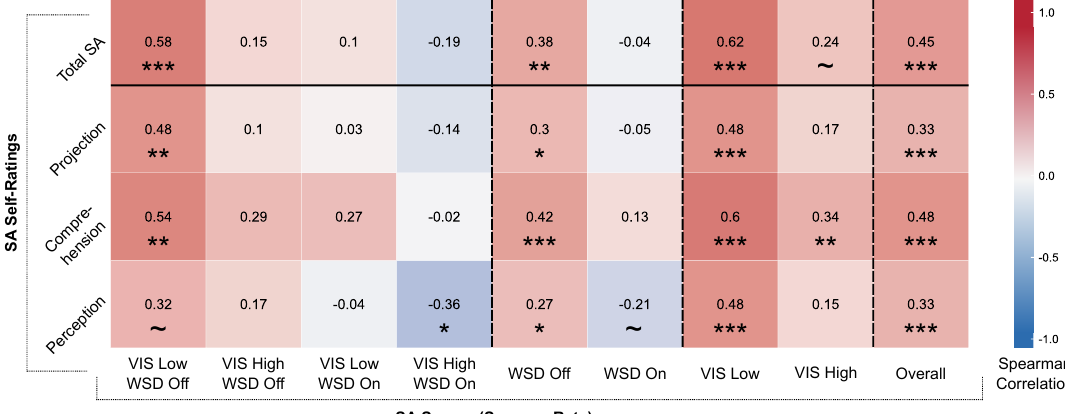
Figure 9. Matrix showing correlations between SA self-ratings and our SAGAT-like SA tests. Cells are labeled and color-coded with Spearman’s rank correlation coefficient values. Significant correlations are indicated as follows: ***: p < 0.001, **: p < 0.01, *: p < 0.05, ~: p <